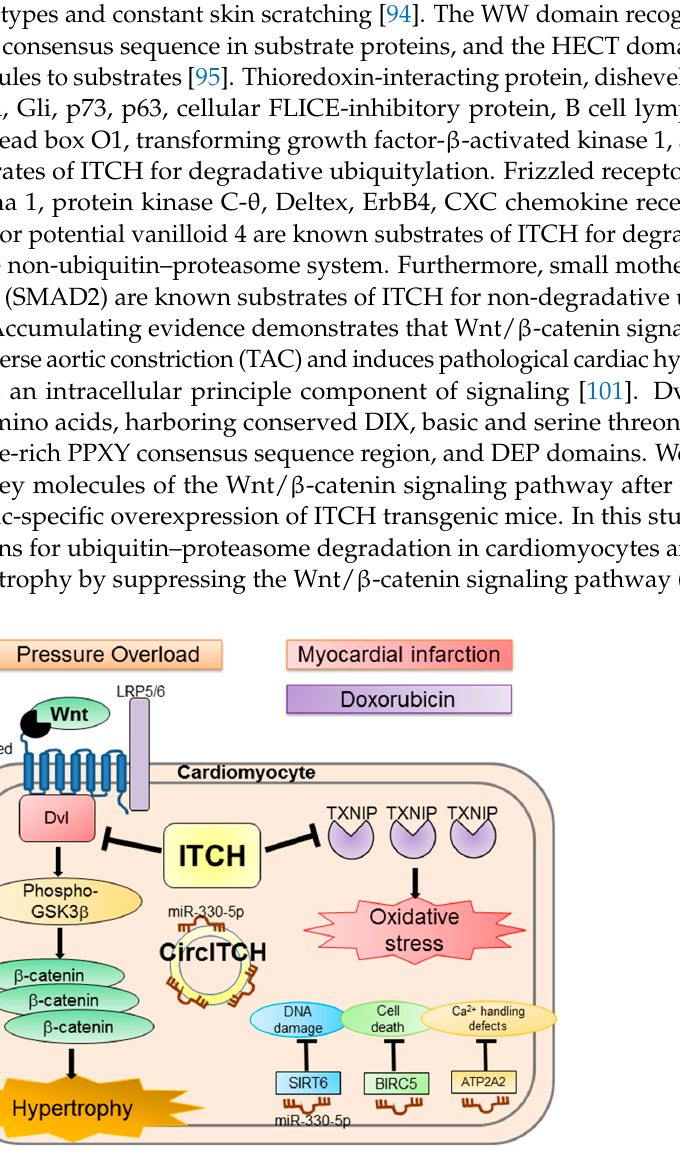
Figure 2. A simplified model depicting the function of ITCH in the development of cardiac hypertrophy, myocardial infarction, and doxorubicin-induced cardiomyopathy. ITCH targets disheveled protein for ubiquitin-proteasome degradation, resulting in inhibition of the Wnt/ β -catenin signaling pathway; ITCH attenuates cardiac hypertrophy induced by pressure overload. ITCH targets thioredoxin-interacting protein for ubiquitin–proteasome degradation and ameliorates reactive oxygen species-induced cardiotoxicity through the thioredoxin system in myocardial infarction and doxorubicin-induced cardiomyopathy models. Circ ITCH absorbs miR-330-5p, resulting in the activation of miR-330-5p targets (SIRT6, BIRC5, and ATP2A2), thereby ameliorating doxorubicin-induced cardiomyopathy by reducing DNA damage, cell death, and calcium handling defects. LRP5/6, low-density lipoprotein receptor-related protein 5/6; Circ ITCH, circular RNA ITCH; miR, microRNA; SIRT6, sirtuin 6; BIRC5, baculoviral IAP repeat containing 5; ATP2A2, ATPase sarcoplasmic/endoplasmic reticulum Ca 2+ transporting 2; Ca 2+ , calcium.